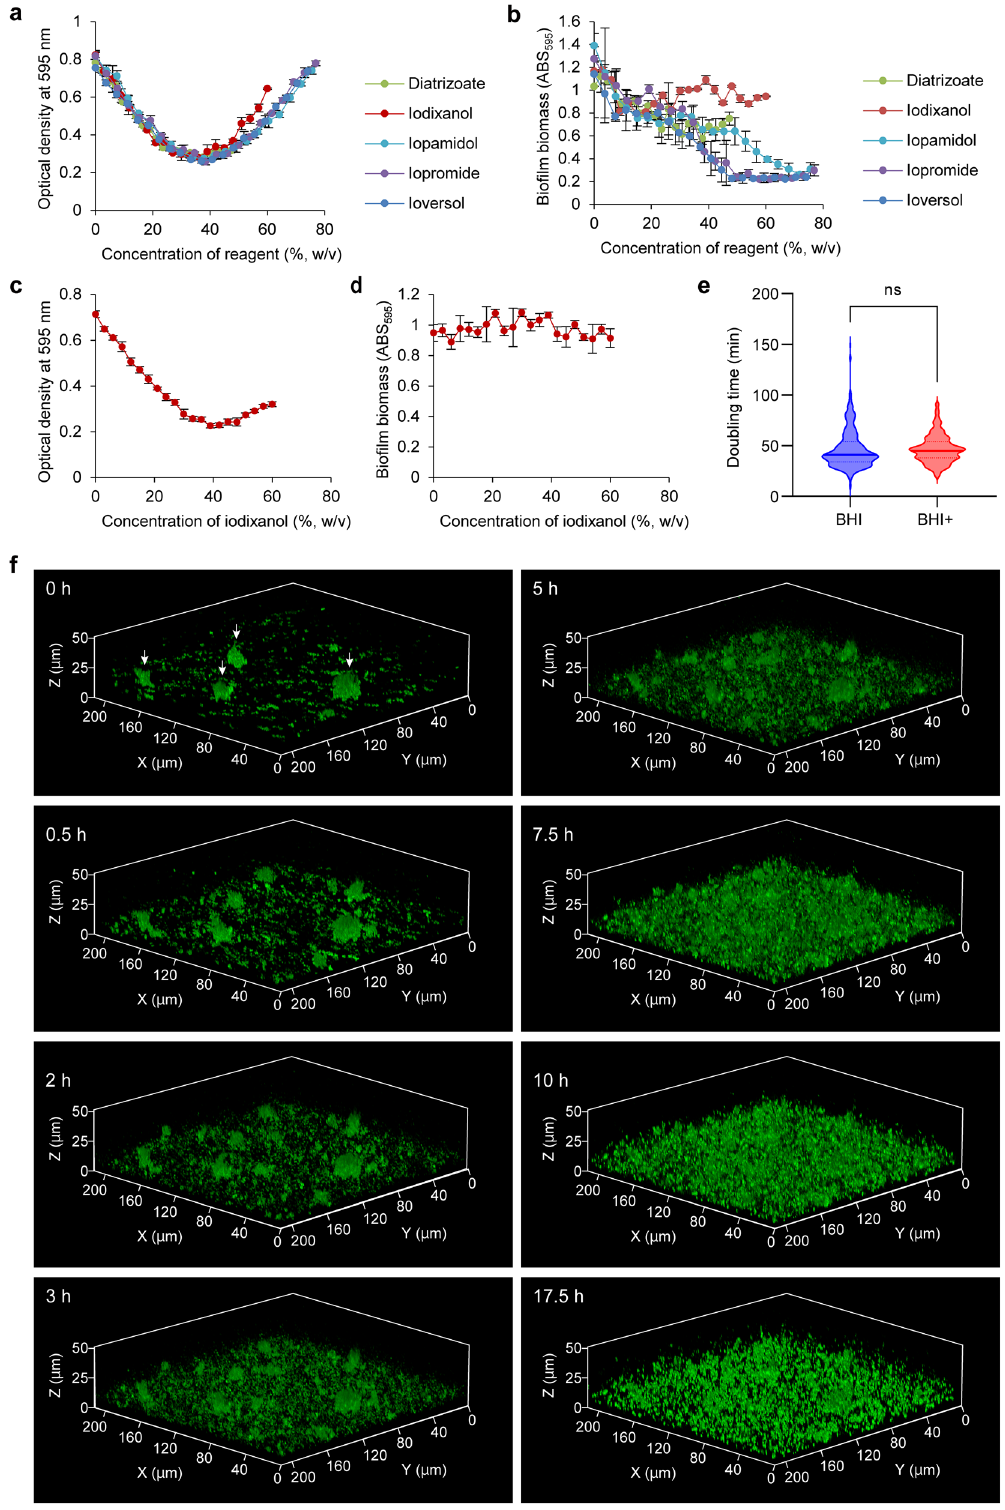
Fig. 2 Live-cell imaging with iCBio fi lm. a Optical density vs concentration of the indicated refractive index-matching media for non- fi xed S. aureus MR4 bio fi lm. b Effects of the clearing reagents on stability of non- fi xed MR4 bio fi lm. c Optical density vs iodixanol concentration for non- fi xed S. epidermidis SE21 bio fi lm. d Effects of iodixanol on stability of non- fi xed SE21 bio fi lm. e Violin plots of the doubling times of SE21 cells measured by optical microscopy at the single-cell level. Cells were grown on BHI agar plates in the absence (BHI, n = 403) and presence of 30.0% (w/v) iodixanol (BHI + , n = 283) under the phase-contrast microscope. ns, not signi fi cant (unpaired two-tailed Student t test). f Live-cell clearing imaging for bio fi lm formation of S. epidermidis SE21 in BHIG containing 30.0% (w/v) iodixanol and 25 μ M ThT in a glass-bottomed dish. 3D images at the indicated time points are shown. Arrows indicate cell clusters formed at the initial phase of bio fi lm formation. Means and standard deviations from four measurements are shown in a – d